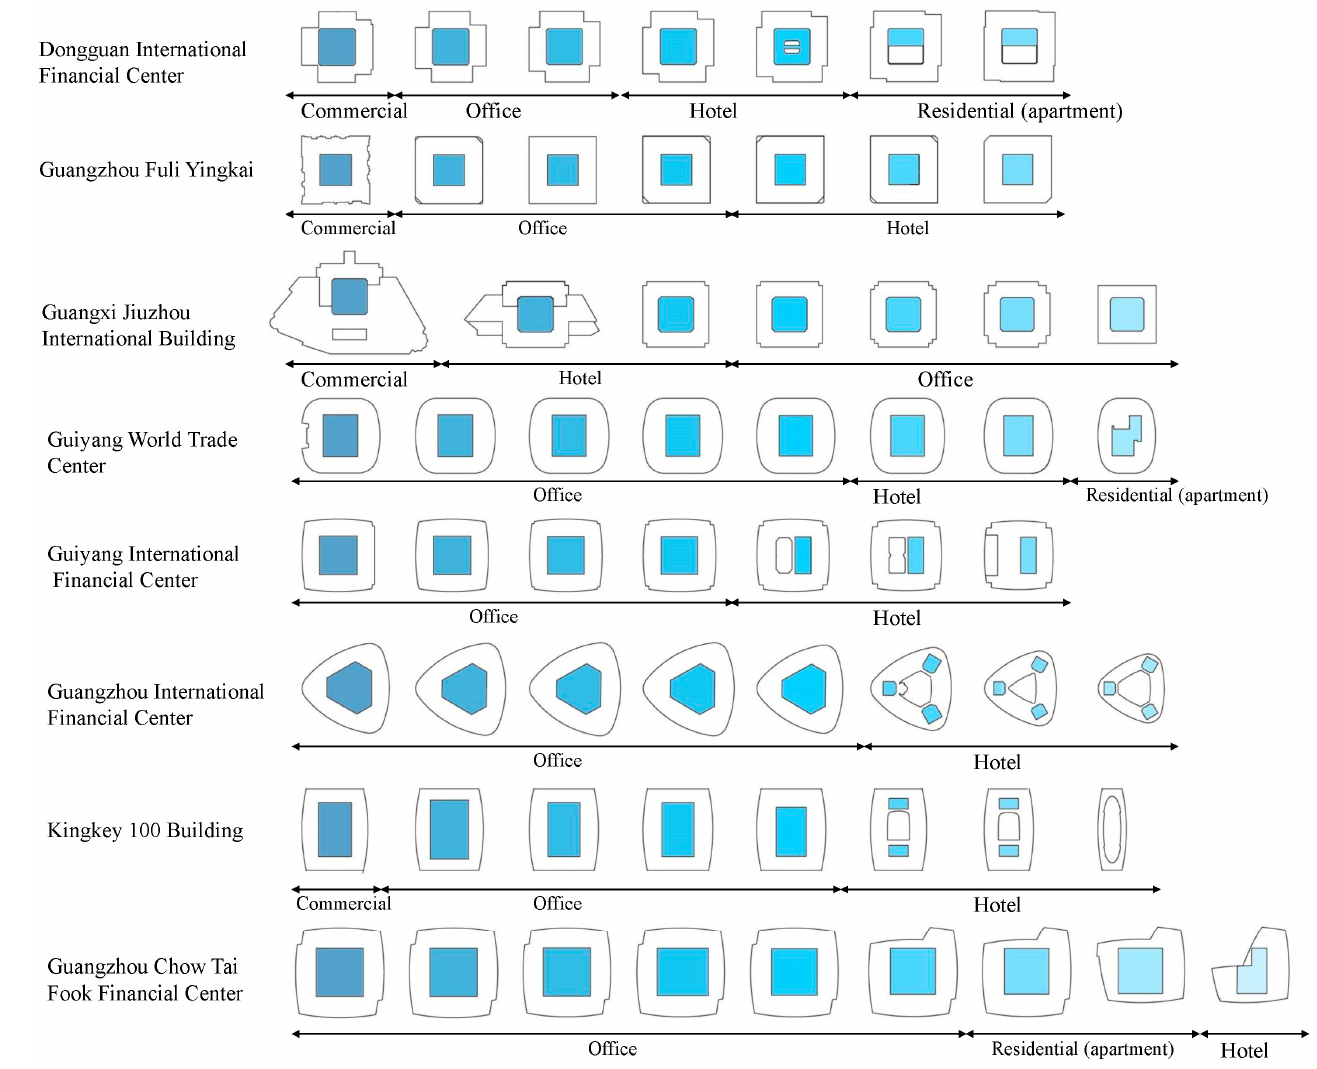
Figure 20. Typical floors division.